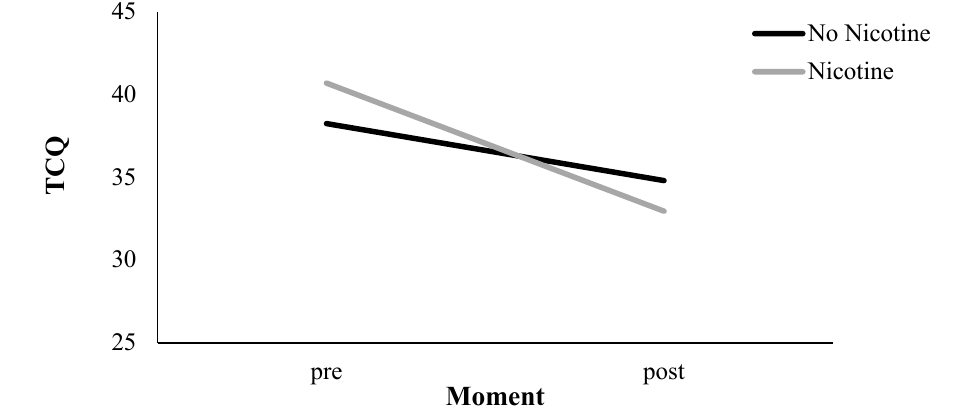
Figure 5. Tobacco cigarette craving (TCQ) pre and post vaping: effect of Nicotine Level.